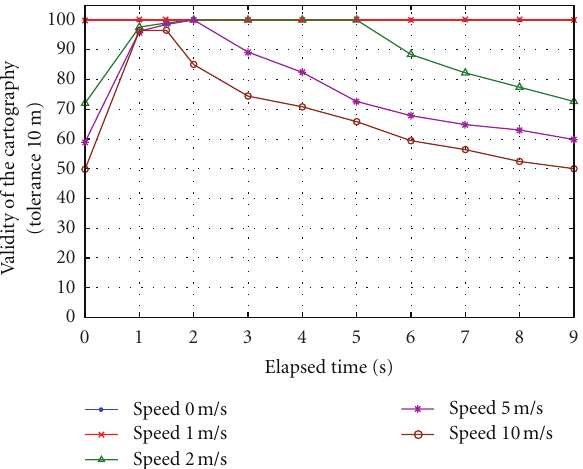
Figure 1: Cartography validity as a function of the elapsed time.